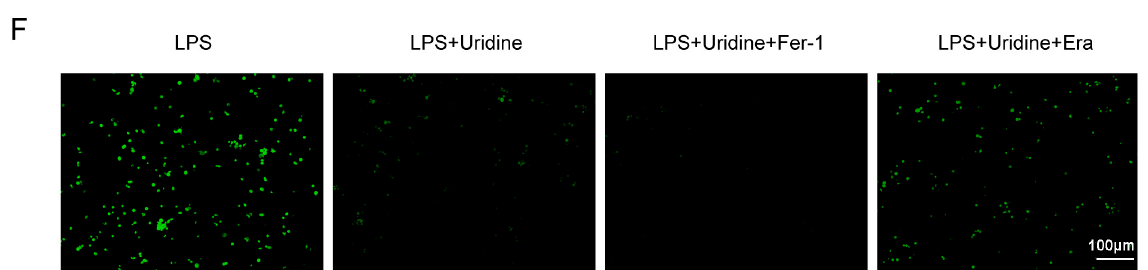
Figure 5. Uridine supplementation markedly suppressed ferroptosis in THP-1 cells after LPS stimulation. ( A ) Immunoblots for NRF2, ASCL4, SLC7A11, HO1, GPX4 and ATCB ( β -actin) in the indicated group either treated with LPS (10 μ g/mL) or uridine (200 μ M) or both. ( B – D ) Relative mRNA expression of GPX4, SLC7A11 and HO1 in the indicated group. ( E ) Cell viability determined by CCK8 assay in the indicated group. Fer-1 (Ferrostatin-1, 5 μ M) and Era (Erastin, 5 μ M) were treated 30 min after uridine supplementation. ( F ) Representative images of fluorescence probe for ROS. n = 6 per group (Data are presented as Mean ± SD, * p < 0.05, ** p < 0.01, *** p < 0.001 compared with indicated group).